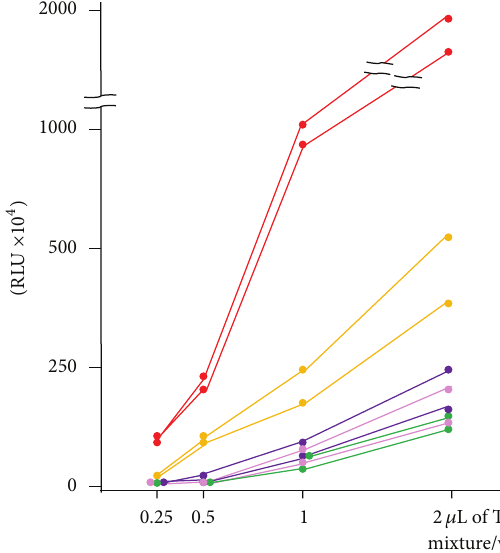
Figure 3: ELISA using biotinylated recombinant proteins of 5 different DM-specific autoantigens. Serial dilution of biotinylated in vitro translation and transcription product for ELISA using 2 representative positive sera from DM patients. Serum dilution was 1:1,000. Red circles: Mi-2 𝛽 . Yellow circles: MJ (NXP-2). Purple circles: TIF1- 𝛼 . Pink circles: MDA5. Green circles: TIF1- 𝛾 . RLU = relative luminescence